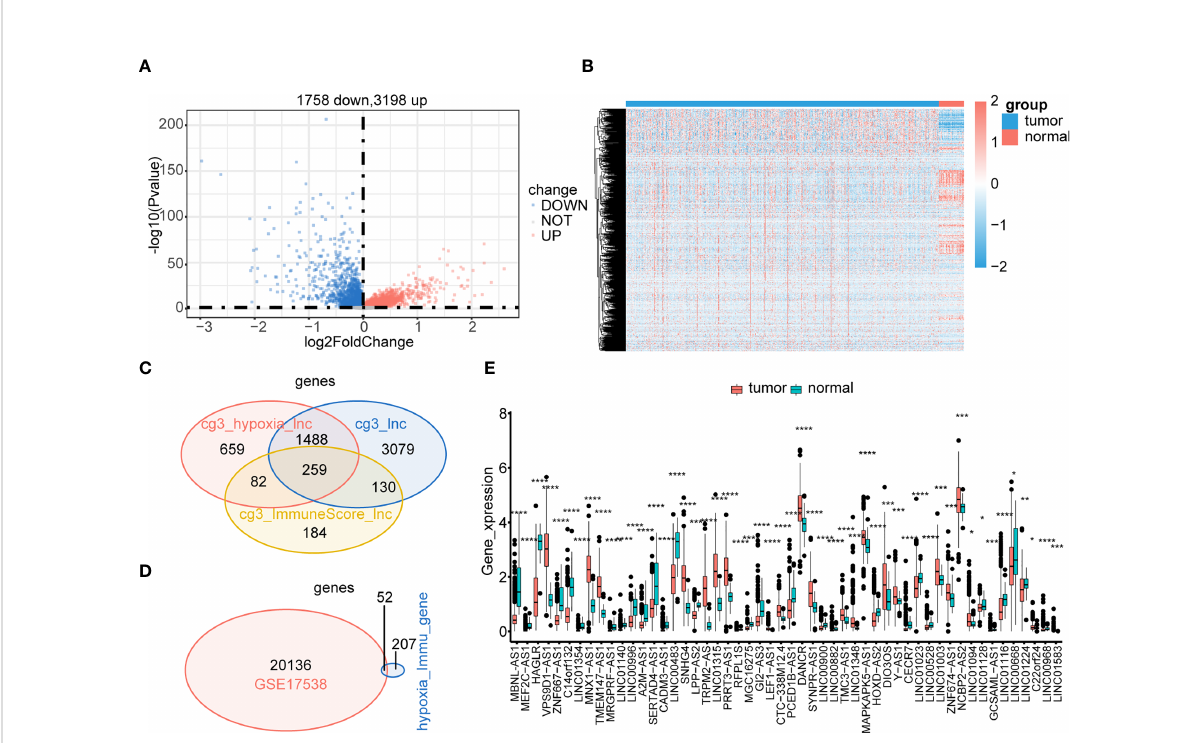
FIGURE 4 Identi fi cation of hypoxia-immune – related DElncRNAs. Expressions of tumor-related lncRNAs are displayed in the volcano plot (A) and heatmap (B) . Hypoxia-immune – related DElncRNAs were identi fi ed in the hypoxia-related lncRNAs group, immune-related lncRNAs group, and tumor- related lncRNAs group of TCGA (C) . Common hypoxia-immune – related DElncRNAs were identi fi ed in TCGA and GSE17538 (D) . The expression levels of 52 common hypoxia-immune – related DElncRNAs in TCGA (E) . ****p<